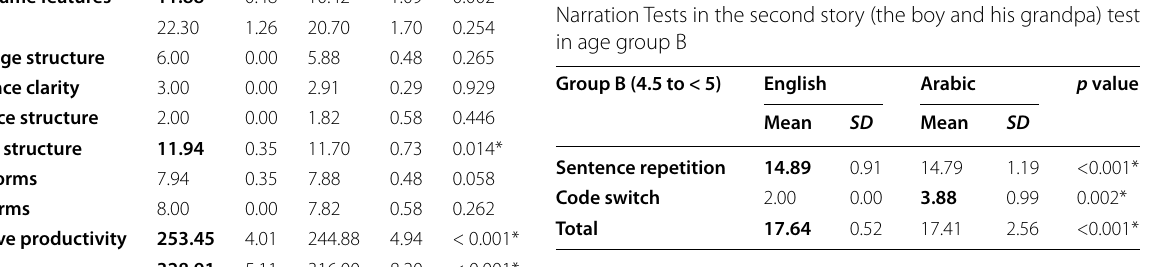
SD standard deviation, bold: higher value, *significant p value < 0.05